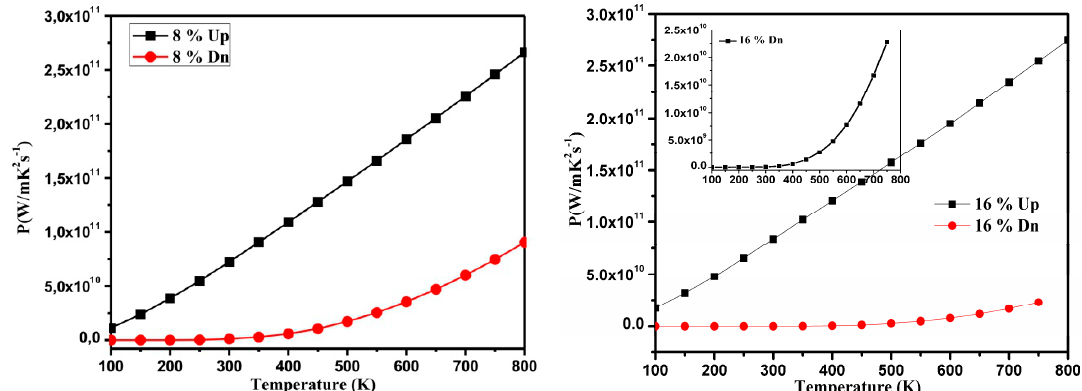
Figure 14. Temperature dependences of power factors (long solid curve ‐ black color for up) and (long = 8% and 16 solid curve ‐ red color for down) for Mn x Zn 1 ‐ x Te (x = 8% and 16 %). solid curve-red color for down) for Mn x Zn 1-x Te (x